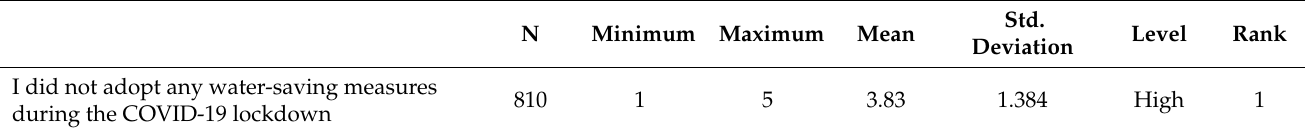
Table 2. Water-use